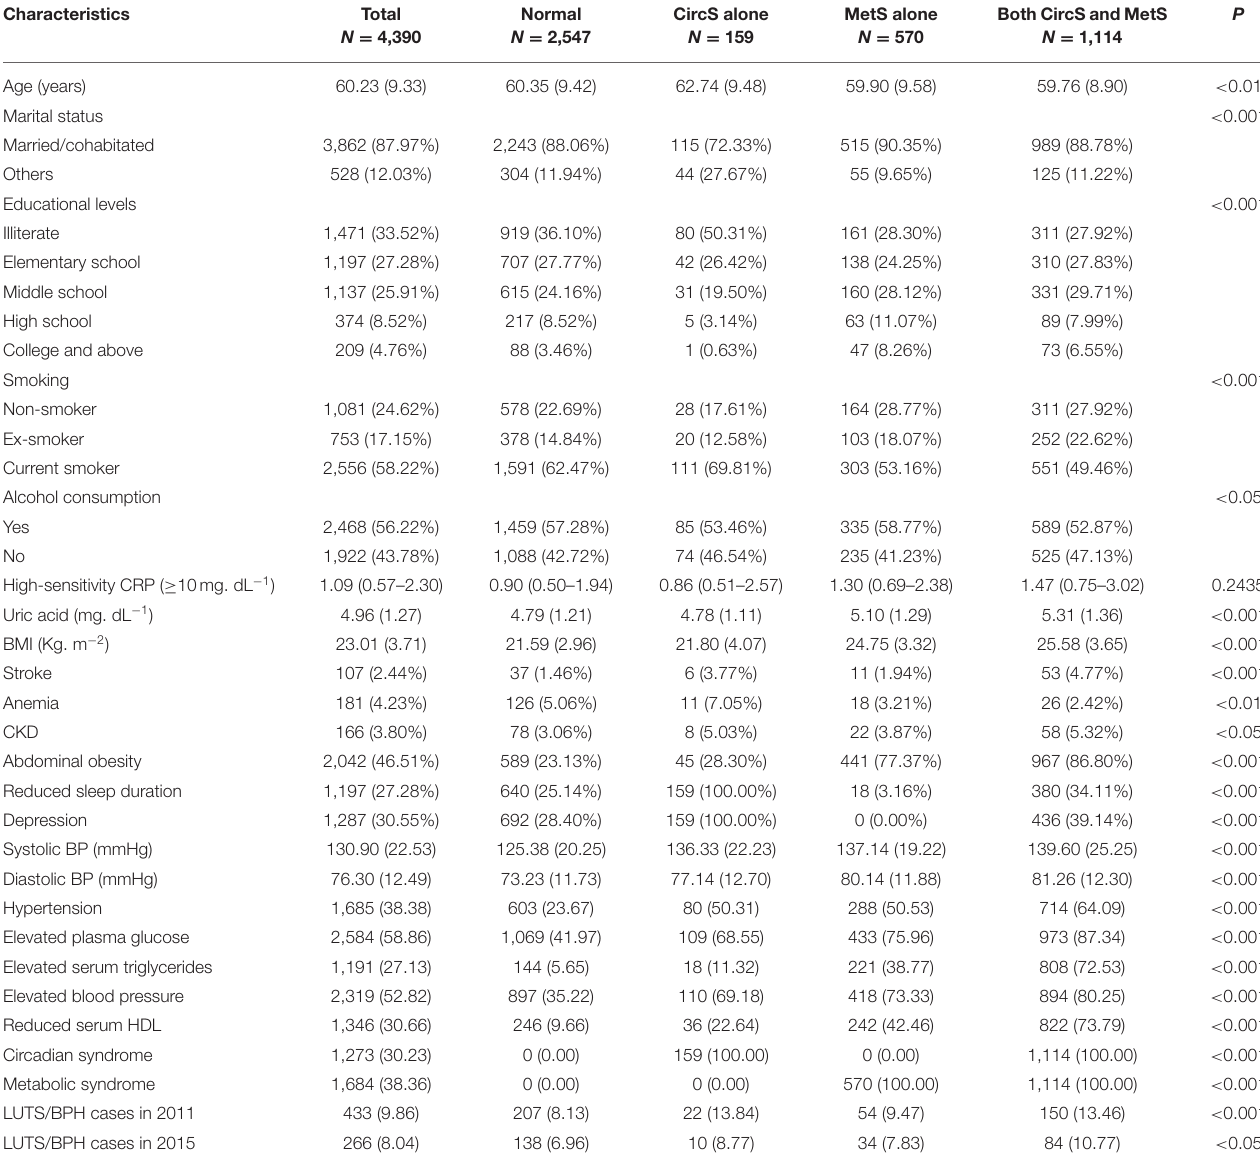
TABLE 1 | Characteristics of the participants attending the baseline survey.